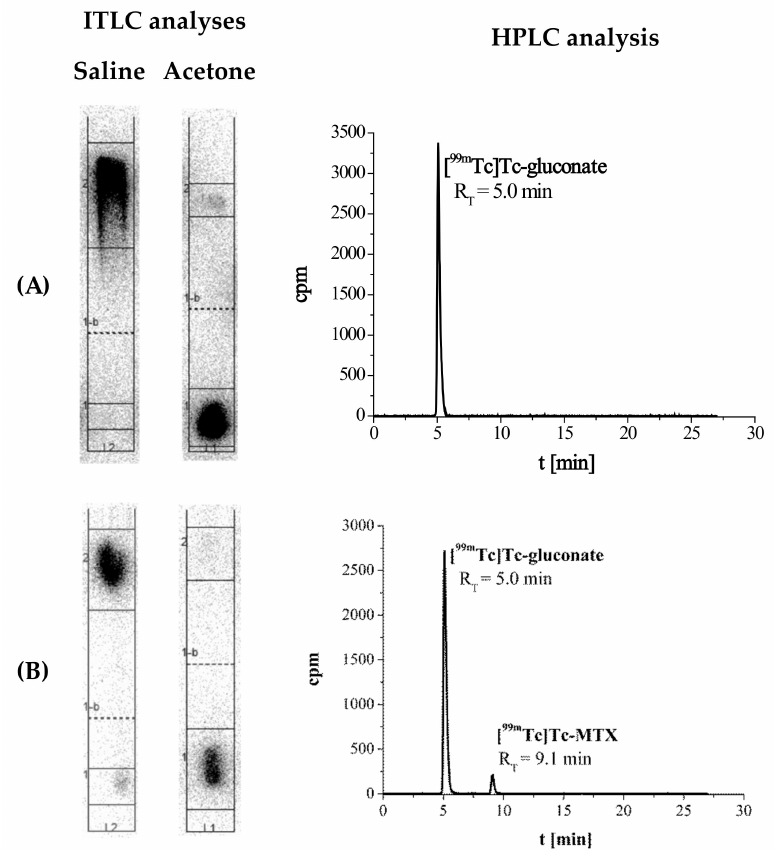
Figure 4. ITLC and HPLC analyses verifying formation of ( A ) intermediate [ 99m